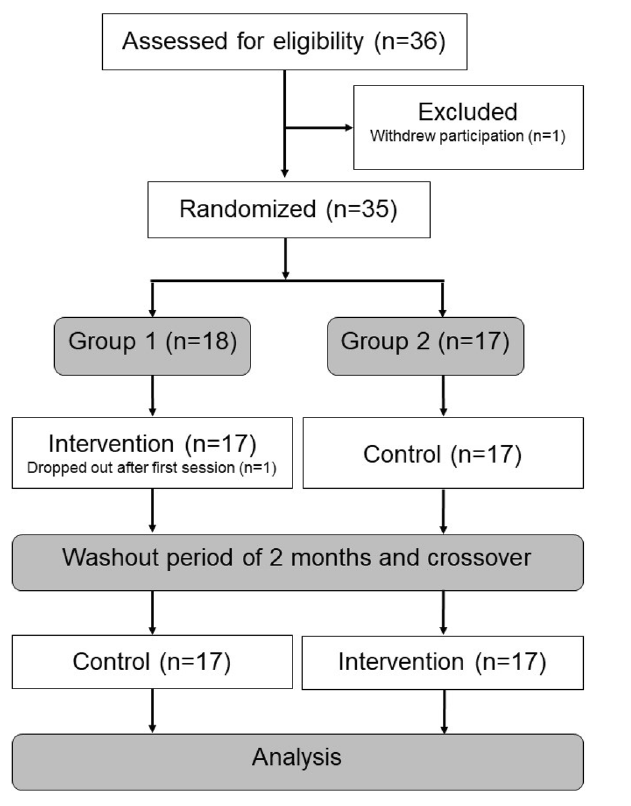
Figure 1. CONSORT flow